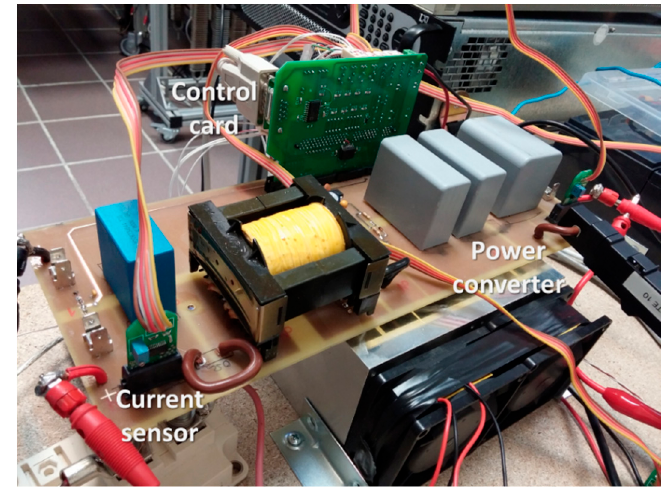
Figure 24. Control card and DC-DC converter.